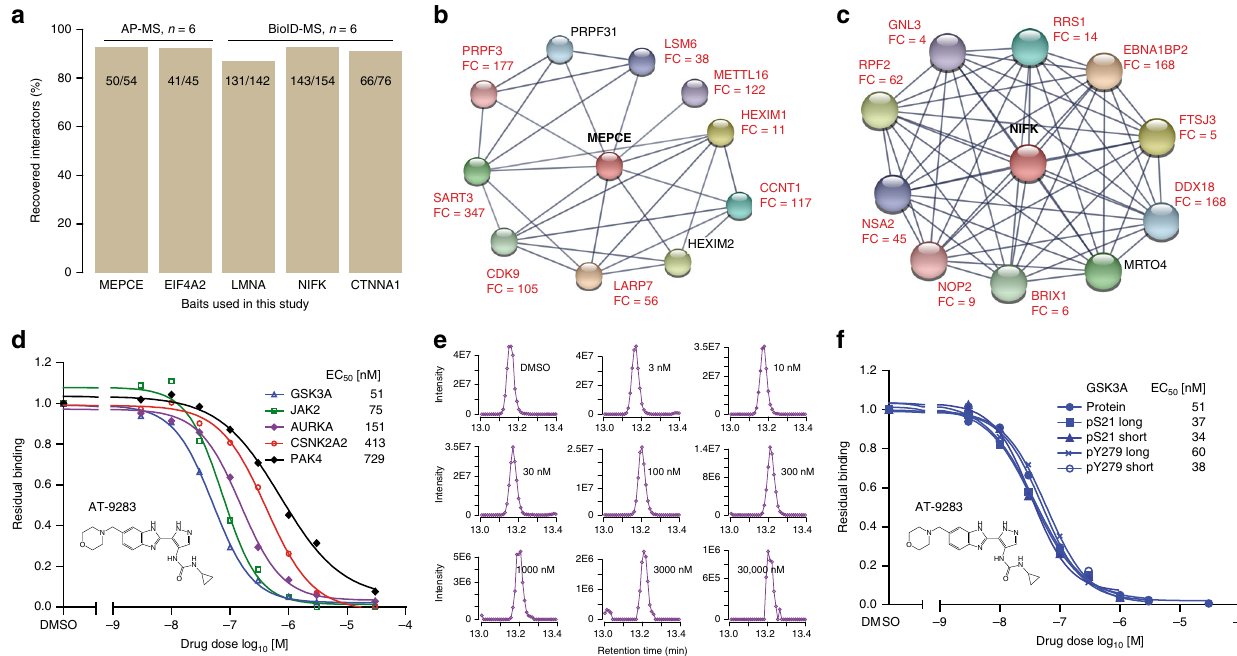
Fig. 4 Application of the micro- fl ow LC – MS/MS system to the analysis sub-proteomes. a Recovery analysis of high-con fi dence interactors obtained by replicate analysis ( n = 6; two biological replicates and three technical replicates) of af fi nity puri fi cations performed using FLAG-tagged human MEPCE and EIF4A2, and BioID proximity labeled human LMNA, NIFK, and CTNNA1 and analyzed by one-shot micro- fl ow LC – MS/MS using 15 min gradients (AP-MS and BioID-MS), compared to results of the same experiments published previously or part of the Human Cell Map project. Numbers inside the bars represent the number of interactors identi fi ed by micro- fl ow LC – MS/MS vs those annotated in the aforementioned resources. b Interaction networks based on the ten most con fi dent interaction partners in STRING for the bait proteins MEPCE (FLAG af fi nity puri fi cation). FC denotes the fold change values of an interaction partner (over control pulldowns) assessed by SAINTexpress analysis. Proteins without FC annotations indicate that they were not identi fi ed as high con fi dent interactors in this micro- fl ow LC – MS/MS study. c Same as b but for NIFK (BioID proximity labeled). d Example dose-response curves of protein kinases that are the targets of the kinases inhibitor AT-9823 obtained by kinobeads competition pulldown experiments and analyzed by micro- fl ow LC – MS/MS system using a 15 min gradient for each drug dose. EC 50 values (effective concentration 50) denote the drug concentration necessary to compete 50% of the binding of a protein to kinobeads. e Extracted ion chromatograms of the AURKA peptide QWALEDFEIGRPLGK from the kinobead experiment in d illustrating the quanti fi cation of this peptide as a function of the applied drug dose. f Dose – response curves akin to d but for four phosphopeptides containing the phosphorylation sites pS21 and pY279 of the protein kinase GSK3A, as well as the aggregated data for the entire